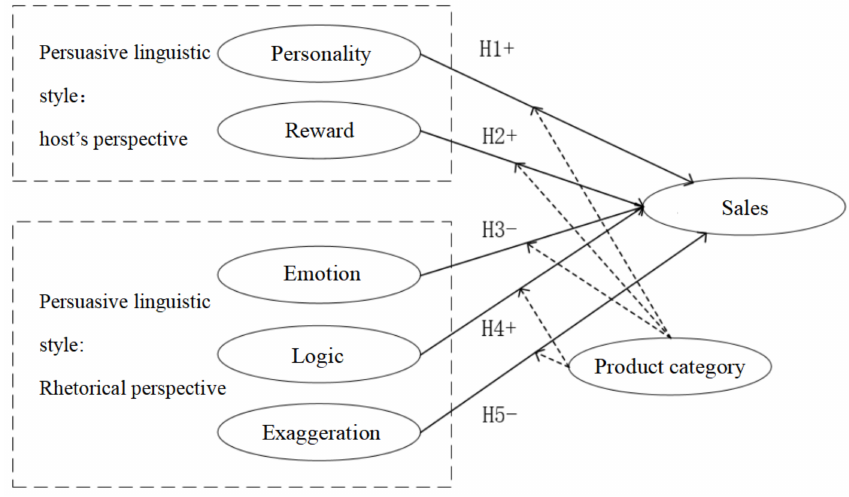
Figure 1. Research Model.